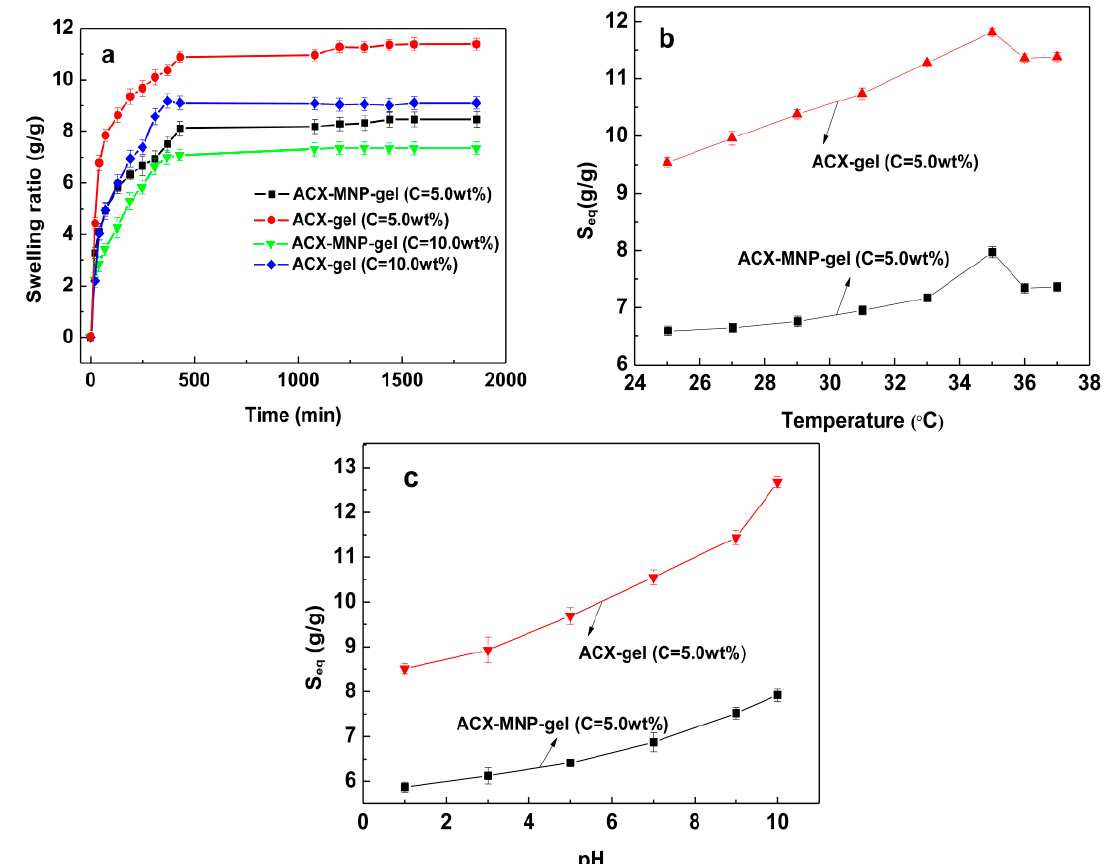
Figure 5. ( a ) The swelling ratio of ACX-gels and ACX-MNP-gels with different C as a function of time; ( b ) The S eq of ACX-gels and ACX-MNP-gels as a function of temperature in neutral pH; ( c ) The S eq of ACX-gels and ACX-MNP-gels as a function of pH at 30 °C.